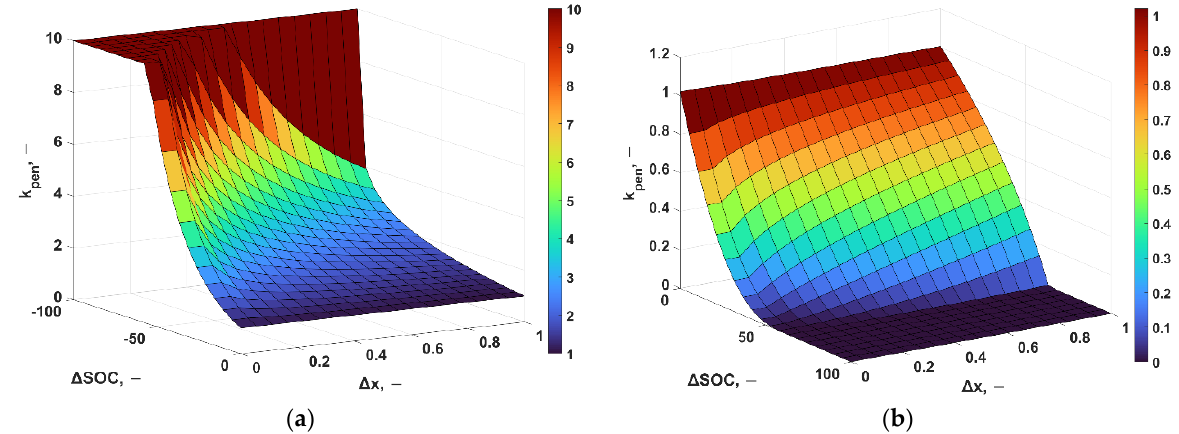
Figure 10. Adaptive function k pen : ( a ) k pen for SoC( x ) < SoC*( x ).; ( b ) k pen for SoC( x ) > SoC*( x